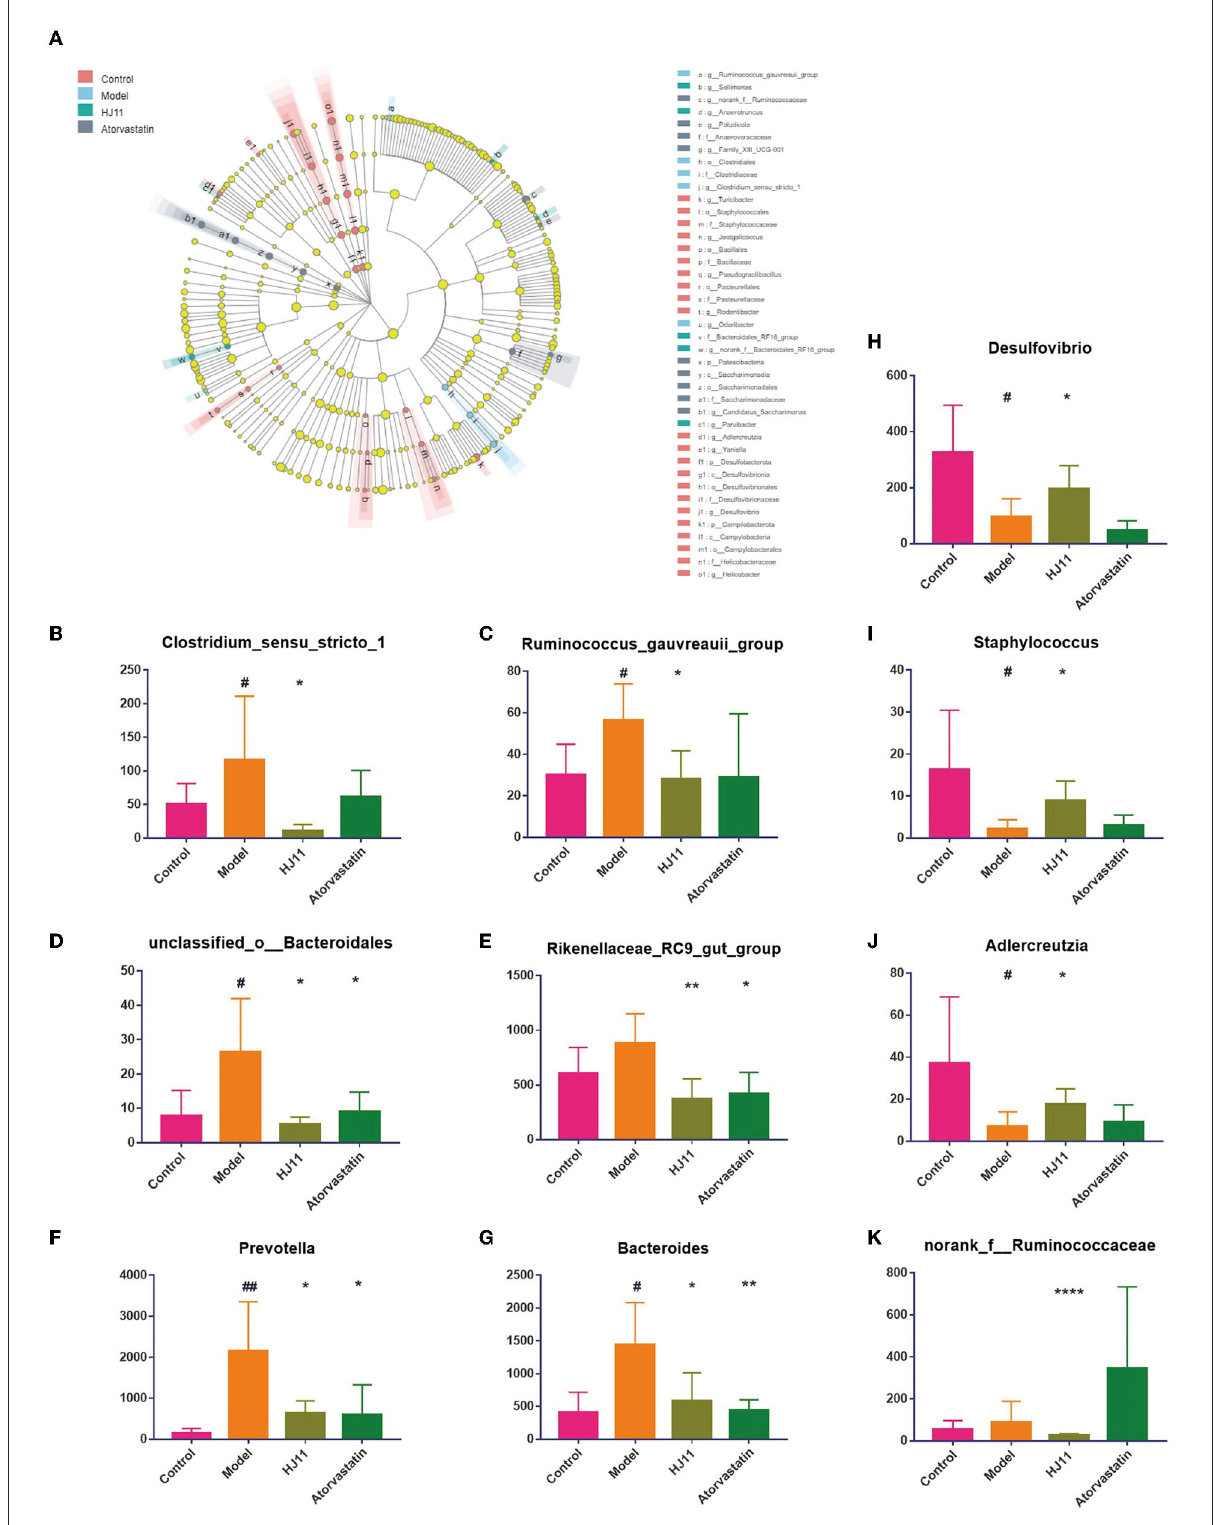
FIGURE6 Differentially abundant bacterial taxa. (A) Linear discriminant analysis effect size from the phylum to the genus level (LDA score > 2.0). (B–K) Relative abundances of gut bacterial genera that were significantly reversed by HJ11 treatment. Student’s t -test, two-tailed. # P < 0.05, ## P < 0.01 compared with the control group; * P < 0.05, ** P < 0.01, **** P < 0.0001 compared with the model